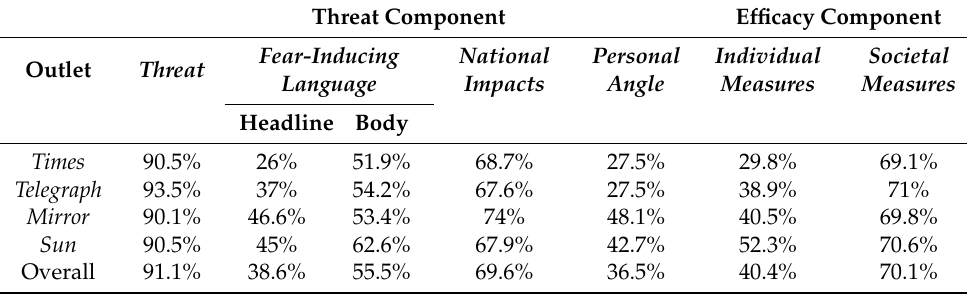
Table 1. Fear Appeals in Coronavirus Coverage.